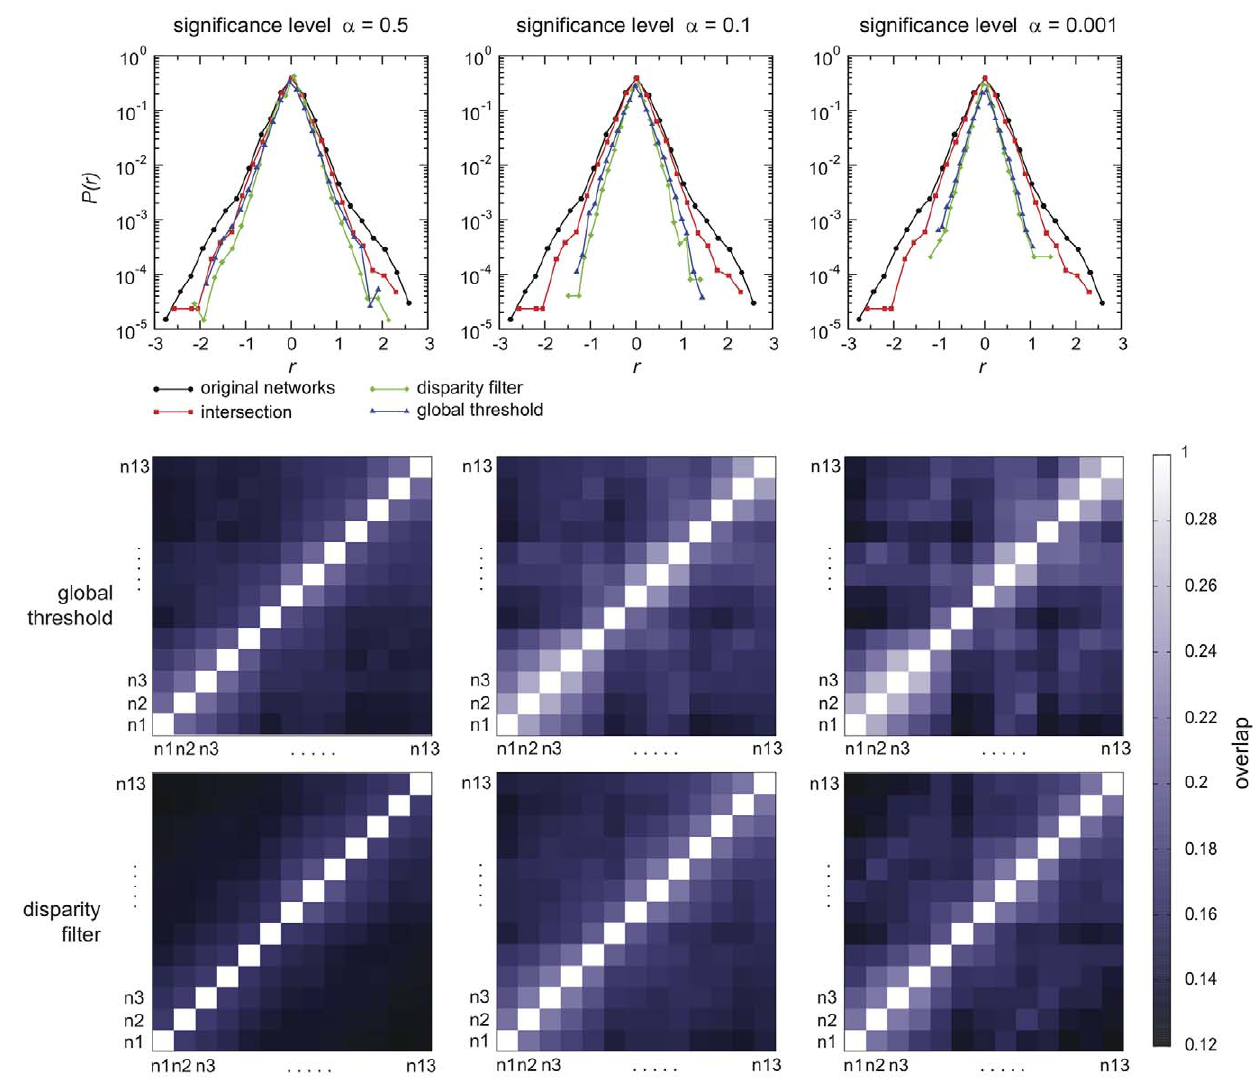
Figure 10. Evolution of monthly network backbones. Top: Distributions of the growth rates of the weights w A of the backbone links, where the network backbone is obtained under different filtering procedures. In each case, growth rates r are measured only for links that are present in two successive backbones. Center and Bottom: Overlap between the backbones of monthly networks. The overlap measures the number of links common to the pair of networks under consideration, normalized by their total number of links. Backbones are obtained either with a global threshold filter (center row) or using a disparity filter (bottom row). Three values of the significance parameter a are considered.